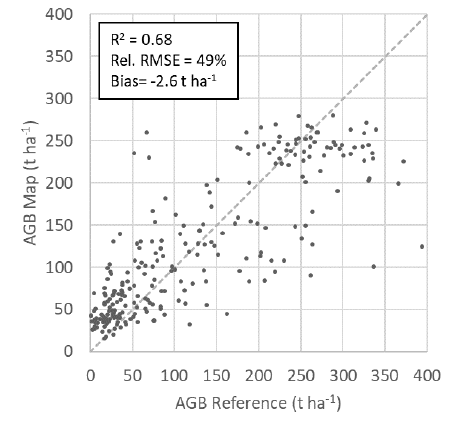
Figure 5. Colombia AGB map for year 2016±1 The R 2 of the final map was 0.68, the Rel. RMSE 49%, and the bias -2.6 t ha -1 (Figure 6). The additional validation using the PPMs showed similar results with R 2 =0.61, Rel. RMSE=34% and Bias=-7.1 t ha -1 .